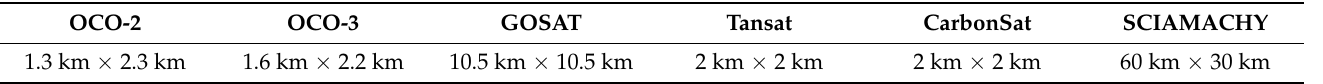
Table 3. The Spatial Resolution Comparison of Some Carbon Satellites.